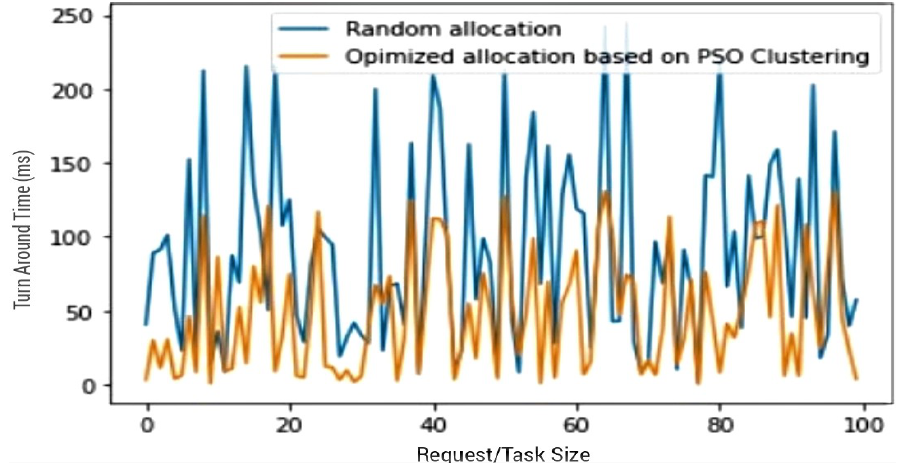
Figure 5. Random allocation vs. PSO clustering technique.